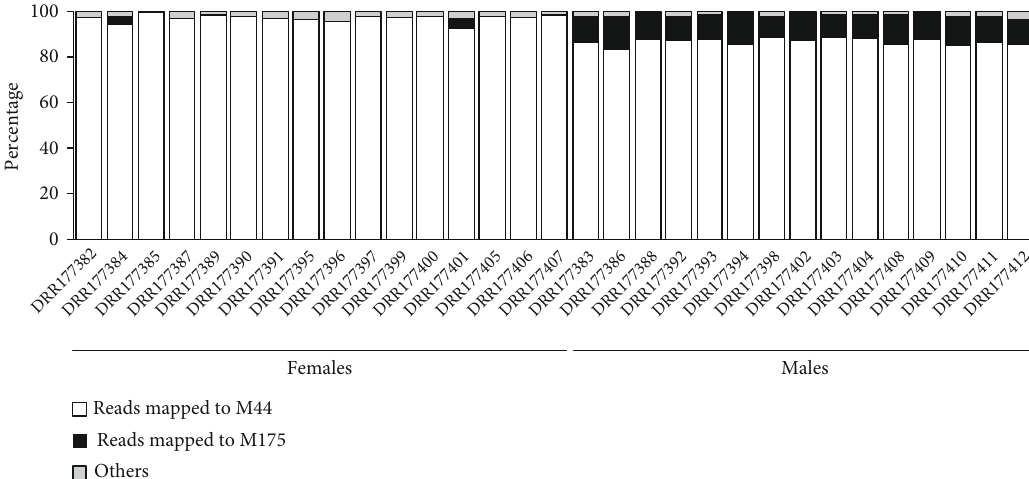
Figure 6: Classi fi cation of the resequenced reads mapped to SLR